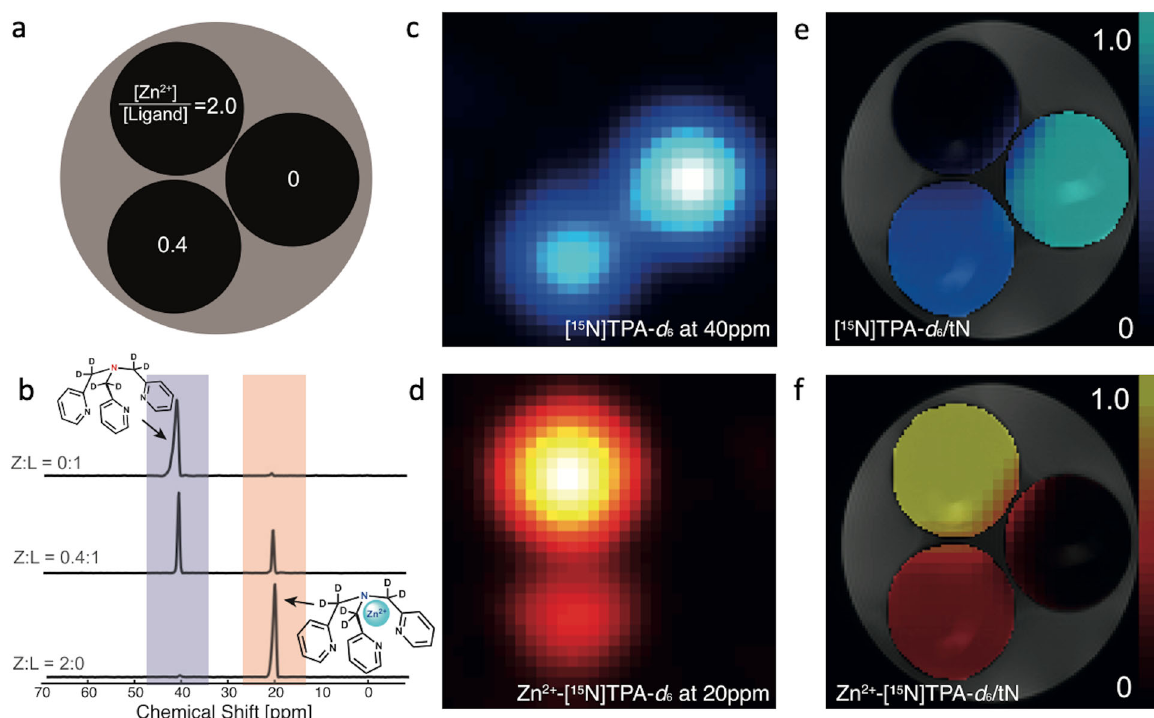
Fig. 4 15 N CSI of HP [ 15 N]TPA- d 6 in HEPES buffered phantom solutions containing different ratios of Zn 2 + /[ 15 N]TPA- d 6 . a A diagram of the phantom arrangement; b 15 N spectra at different Zn 2 + to [ 15 N]TPA- d 6 ratios; c 15 N images of free, uncomplexed [ 15 N]TPA- d 6 (40 ppm); d images of the Zn 2 + -[ 15 N] TPA- d 6 complex (20 ppm). e and f show the ratiometric images of each species, normalized by the total 15 N signal (tN).